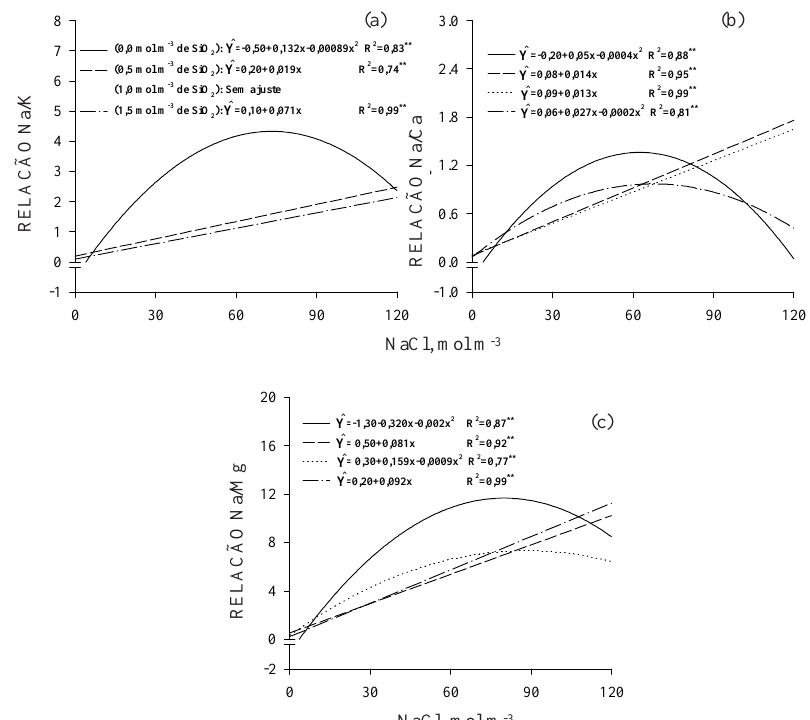
Figura 4. Relações Na/K (a), Na/Ca (b) e Na/Mg (c), considerando a concentração de NaCl e de SiO